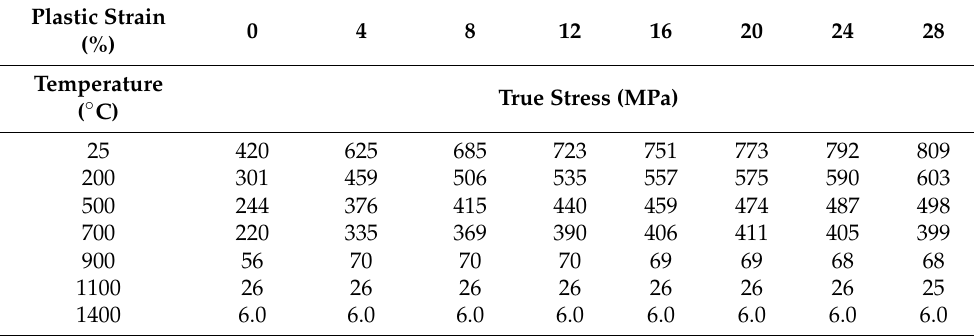
Table 9. Flow stress of SA508-3 at different temperatures.